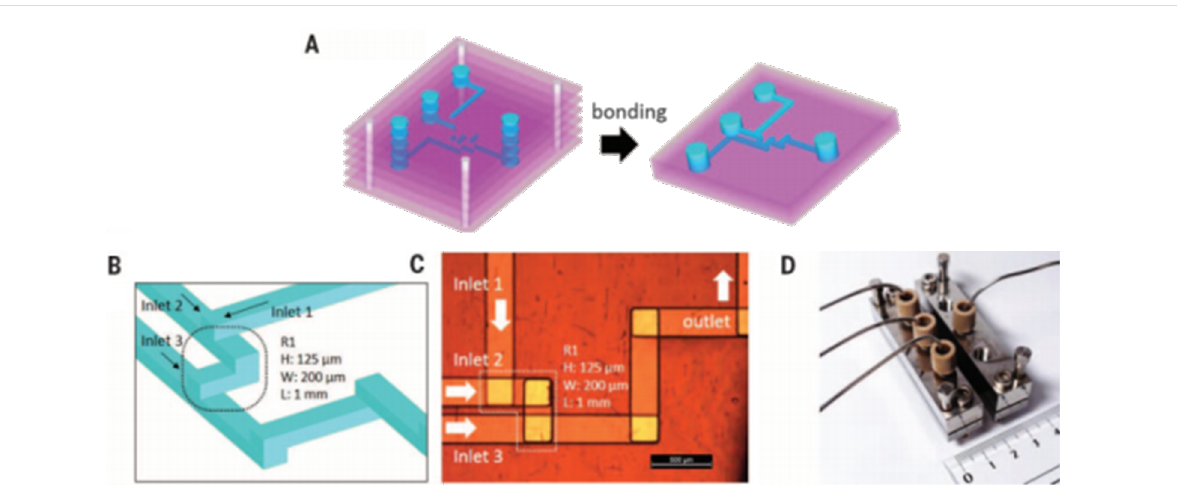
Figure 2: Chip microreactor (CMR) fabricated with six layers of polyimide films. (Reproduced with permission from [43], copyright 2016 American As- sociation for the Advancement of